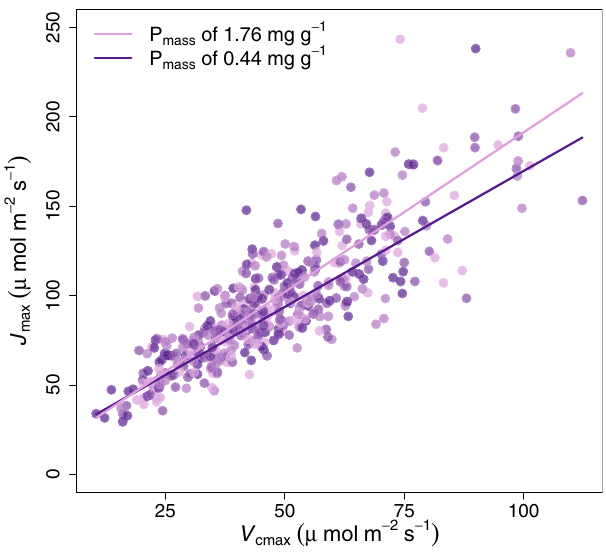
Fig. 3 | The correlation between J max and V cmax for leaves with different leaf P concentrations. The colour scheme indicates low leaf P mass in purple shades with increasing P mass corresponding to progressively lighter shades of purple to plum. Eachpointsisaspecies-sitemean.Thelinesshownareforthetwoend-memberleaf P mass classes:meanlowP mass of0.44±0.11(s.d.),and meanhighP mass of1.76±0.55 (s.d.). The OLS regressions shown are: J max =17.5+1.52* V cmax for low P mass (r 2 =0.82), and J max =12.8+1.79* V cmax for high P mass (r 2 =0.71), with P <0.0001 for both regressions. V cmax and J max are temperature-normalised to 25°C (see meth- ods).Theslopetermsofthelinesaresigni fi cantlydifferentat P =0.0355usingP mass class as a categorical variable in interaction with the independent